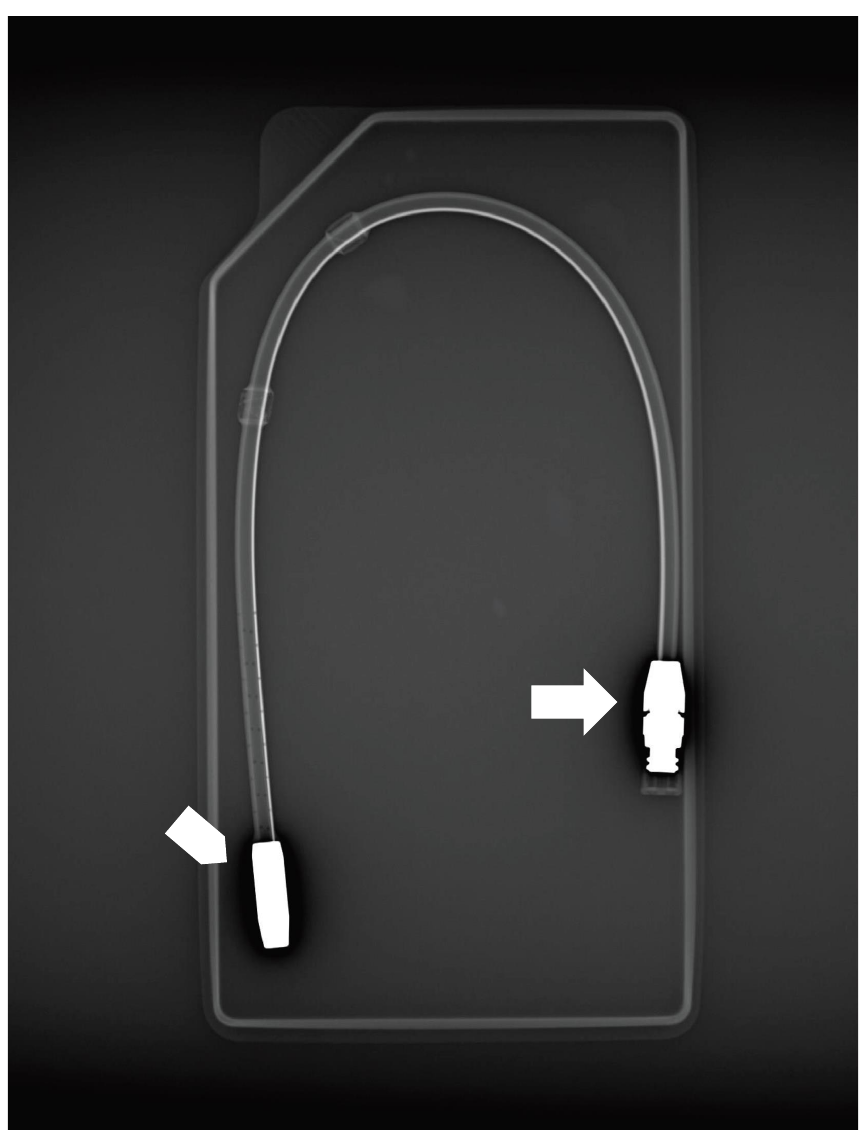
Figure 2: Conventional X-ray of the peritoneal dialysis catheter that demonstrates the radiopaque tip tungsten ballast (arrowhead) and, on the other extremity, the titanium connector